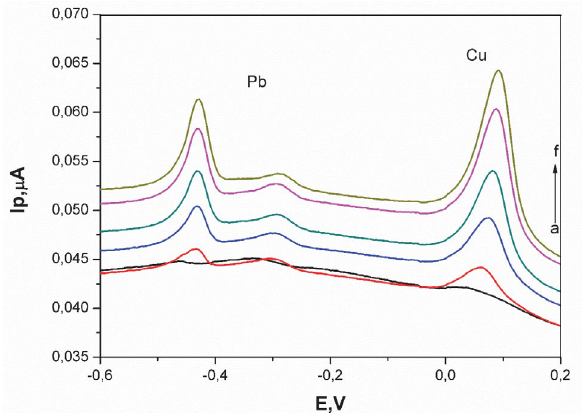
table 3. Results of Pb recoveries obtained with DPASV method in laboratory-made synthetic samples Pb Cu Sample